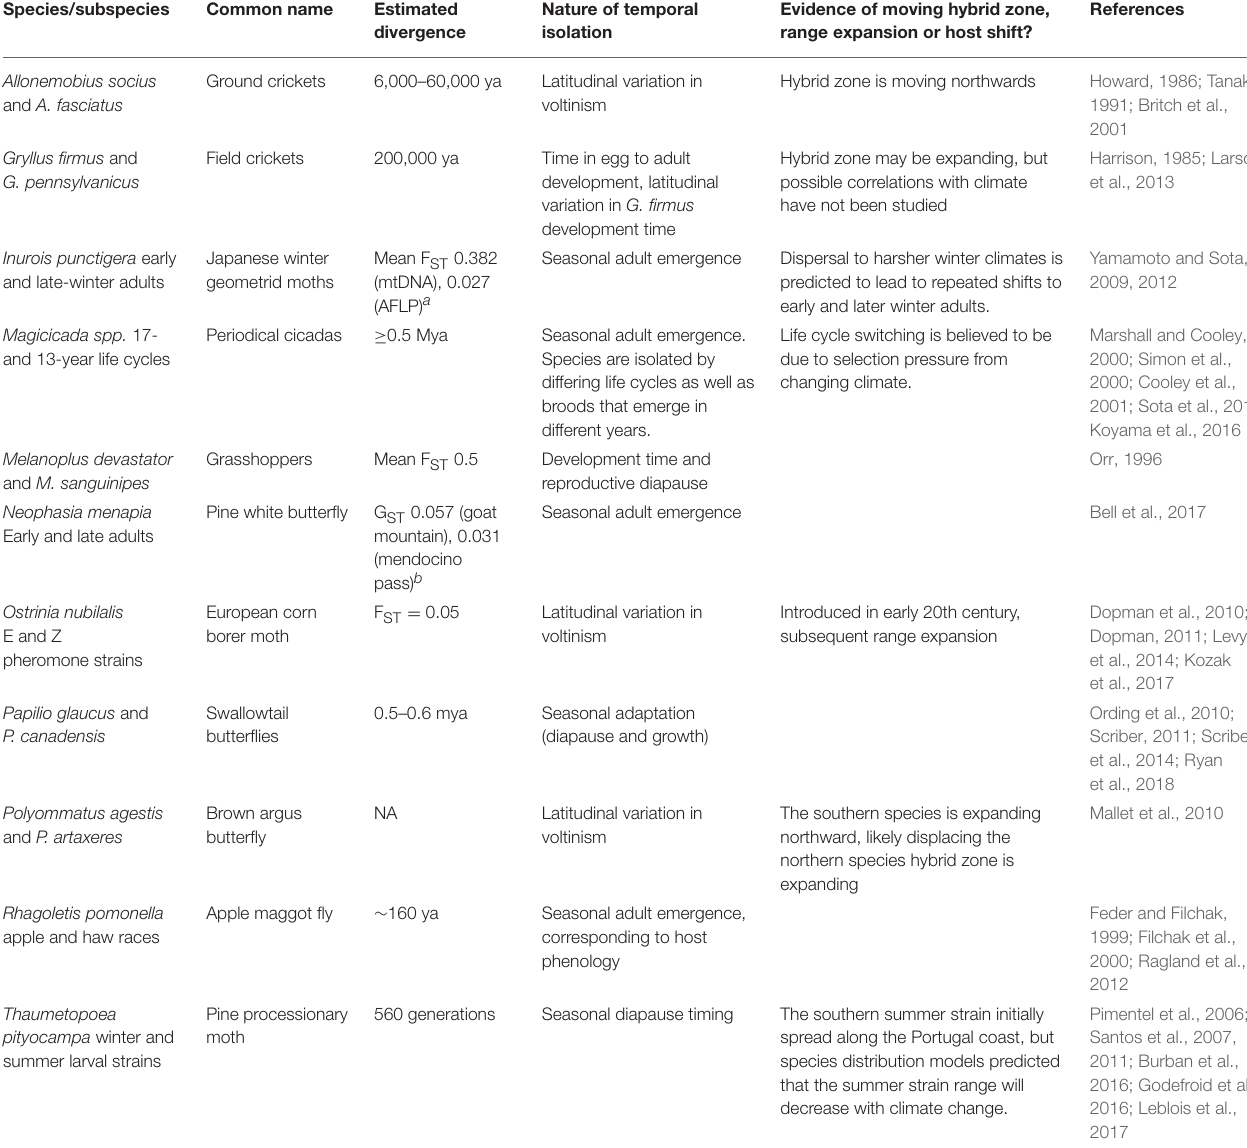
TABLE 1 | Examples of species or subspecies temporally isolated through seasonal